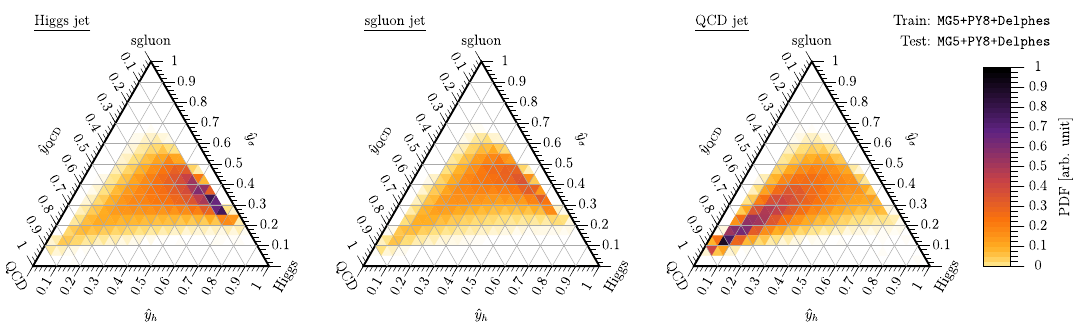
Figure 9 . Ternary plots of the predicted label vector ^ y of the MLP for the Higgs jet (left), sgluon jet (center), and QCD jet